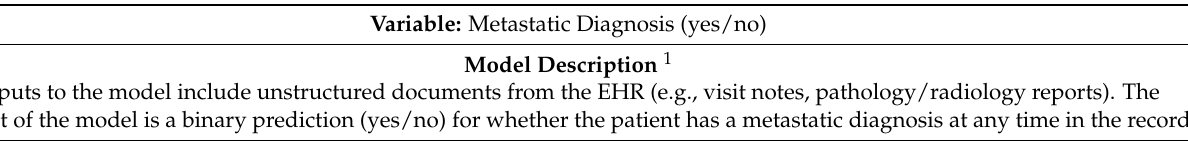
Table 4. Evaluation framework template for the illustrative